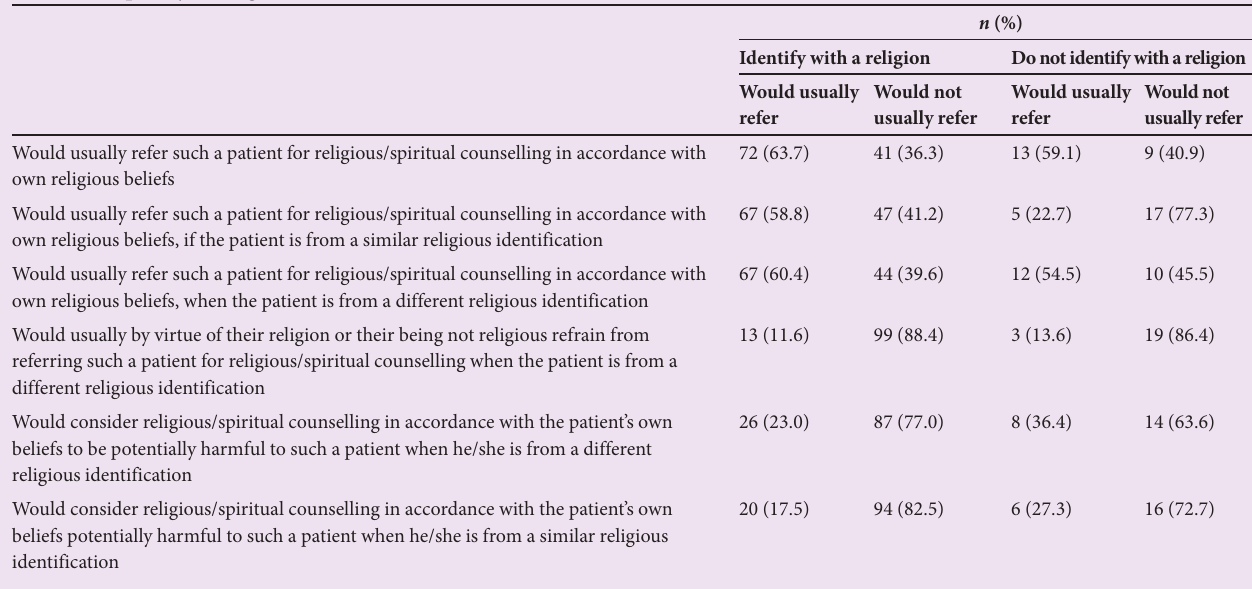
Table 2. Frequency of religious self-identification v. referral